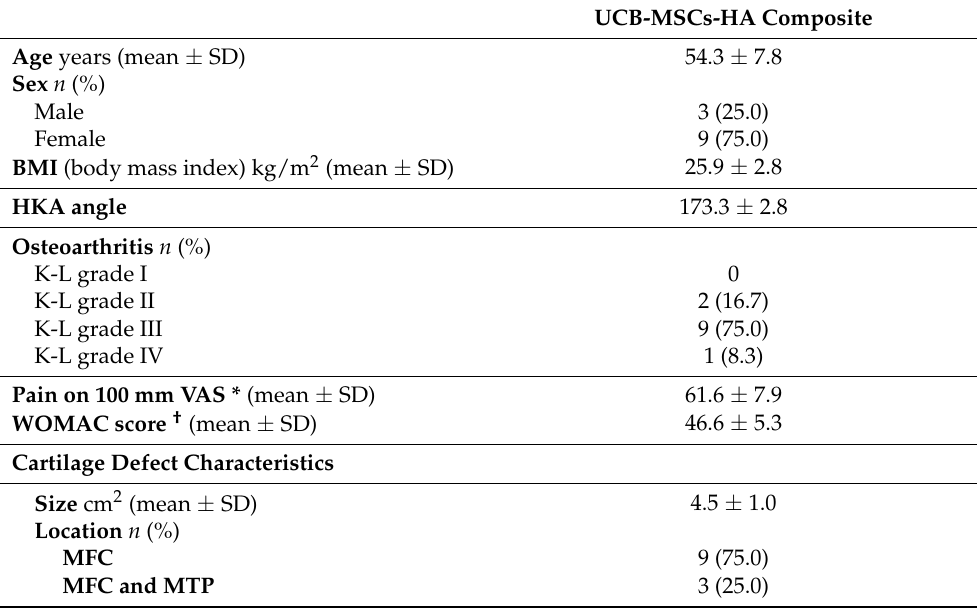
Table 1. Demographics and Baseline Characteristics of patients of this